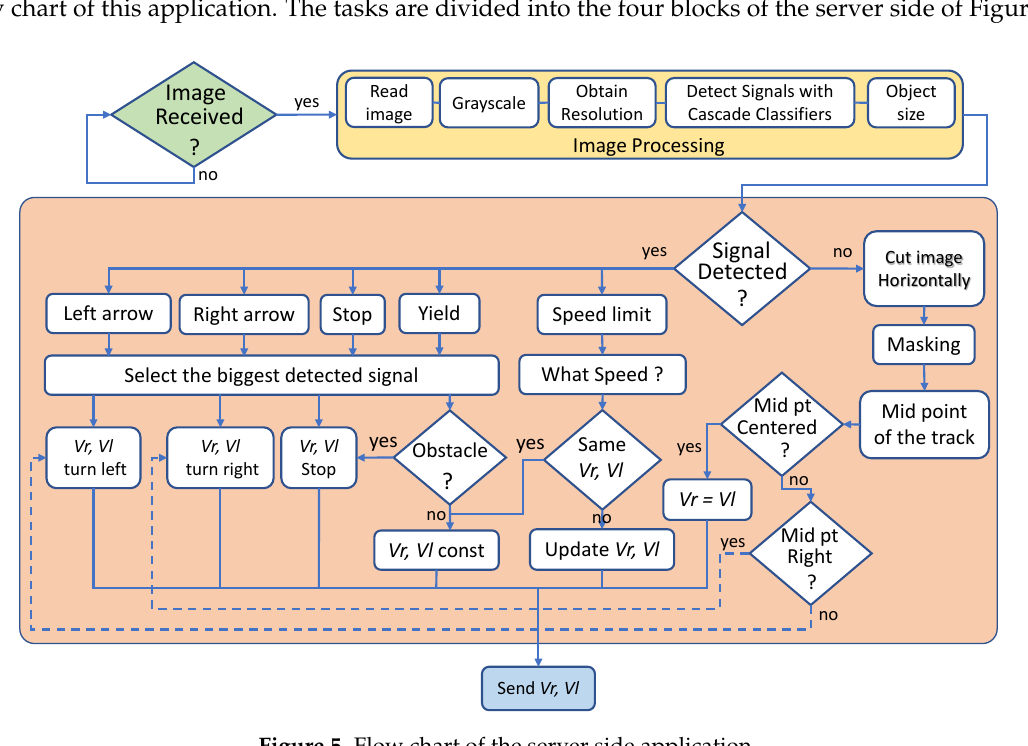
Figure 5. Flow chart of the server side